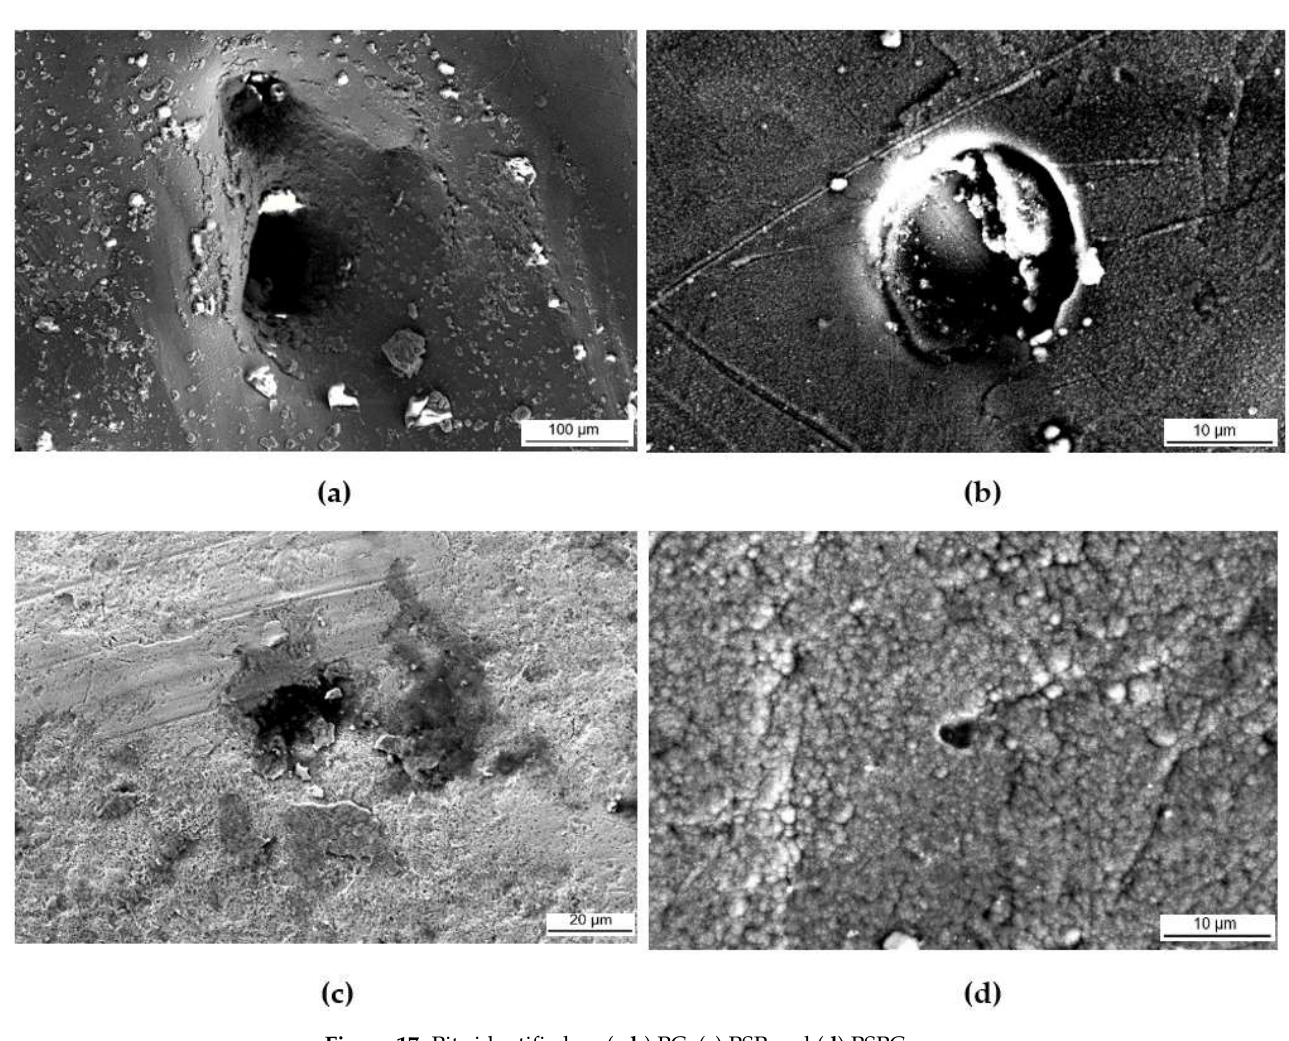
Figure 17. Pits identified on ( a , b ) PC, ( c ) PSP and ( d ) PSPC.